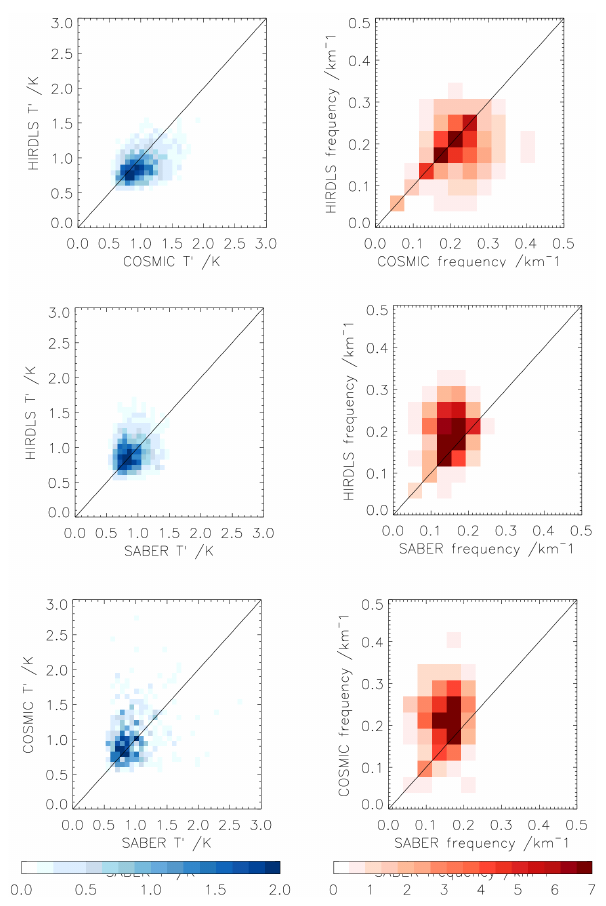
Fig. 5. ST analysis output for (top panel) HIRDLS-COSMIC, (mid- dle panel) HIRDLS-SABER and (bottom panel) COSMIC-SABER profile pairs. The left plot shows a density plot of the peak tempera- ture perturbation in each paired profiles, and the right a density plot of the vertical frequencies of these temperature perturbation peaks. Scales are as a percentage of the total number of analysed profile- pairs in each